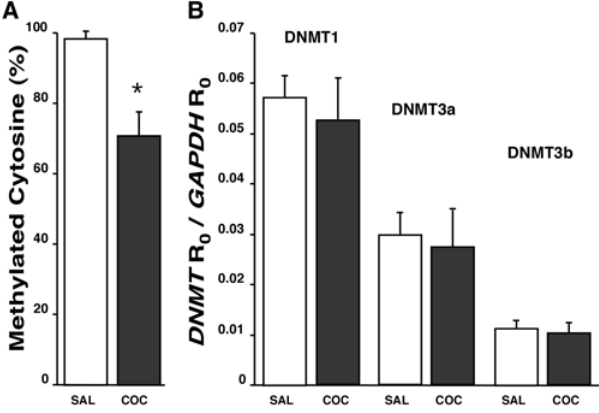
Figure 4. Global DNA methylation and DNMT expression levels in the hippocampal pyramidal layer of P3 offspring from saline-injected or cocaine-treated dams. (a) Global levels of cytosine methylation in DNA samples of control and cocaine groups each expressed as percentage relative to the methylation signal in Epigentek’s methylated DNA standard. (b) Expression levels of DNA methyltransferases DNMT1, DNMT3a, and DNMT3b each calculated as a ratio relative to GAPDH as internal standard. Similar results were obtained with ß-actin used as internal standard. Each column represents mean 6 SEM of 10 samples. *p , 0.05 compared to the saline-control group.